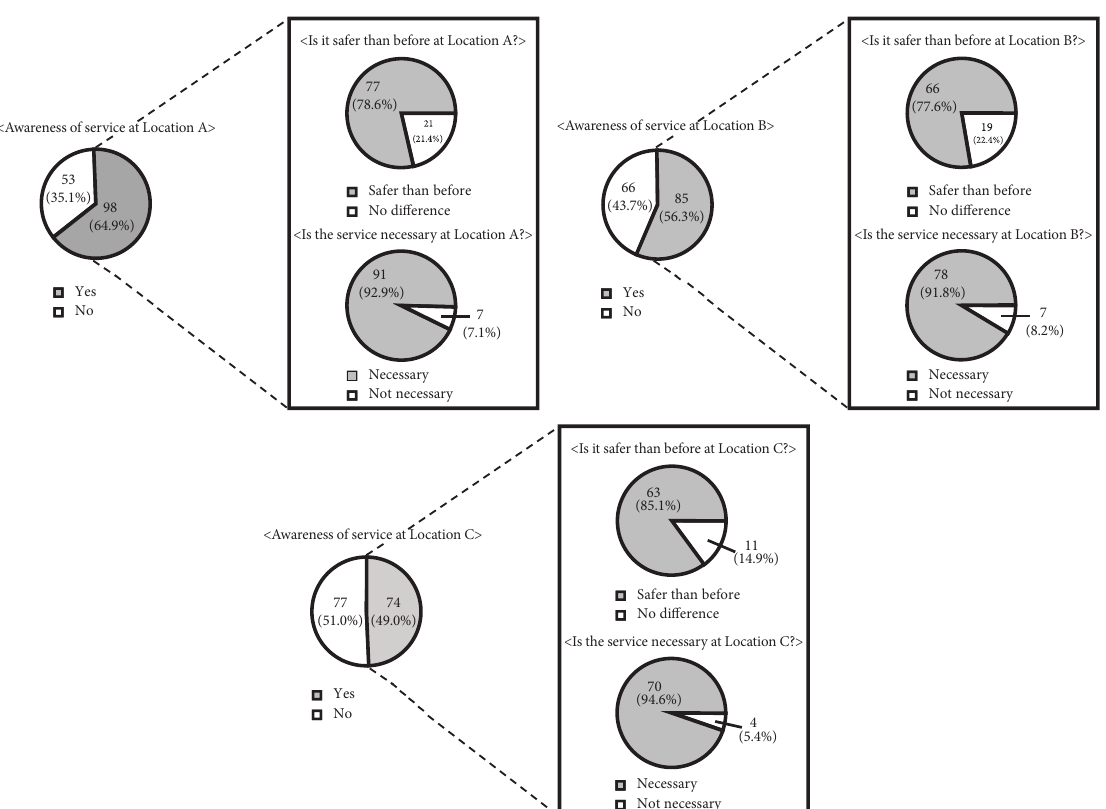
Figure 12: Perception of service at each location.